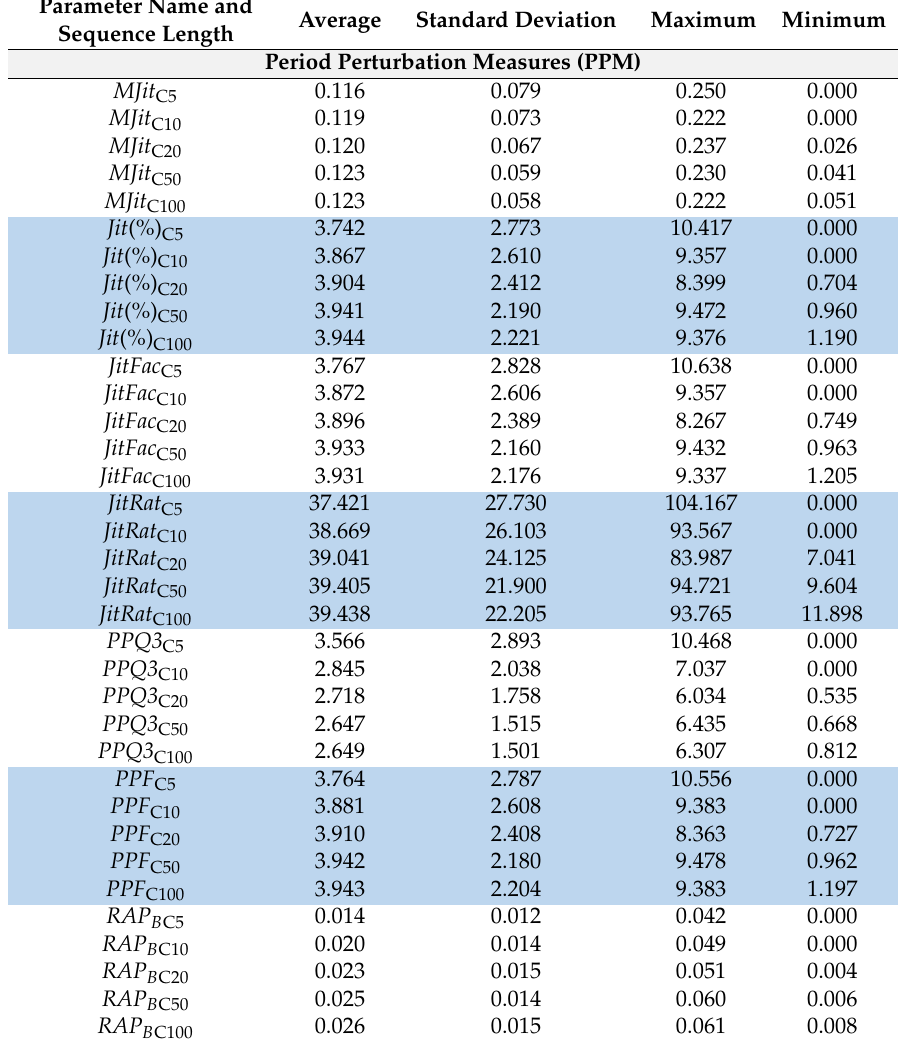
(Table A1), amplitude perturbation measures (Table A2) and energy perturbation measures (Table A3). Table A1. Group values of all parameters for Period Perturbation Measures